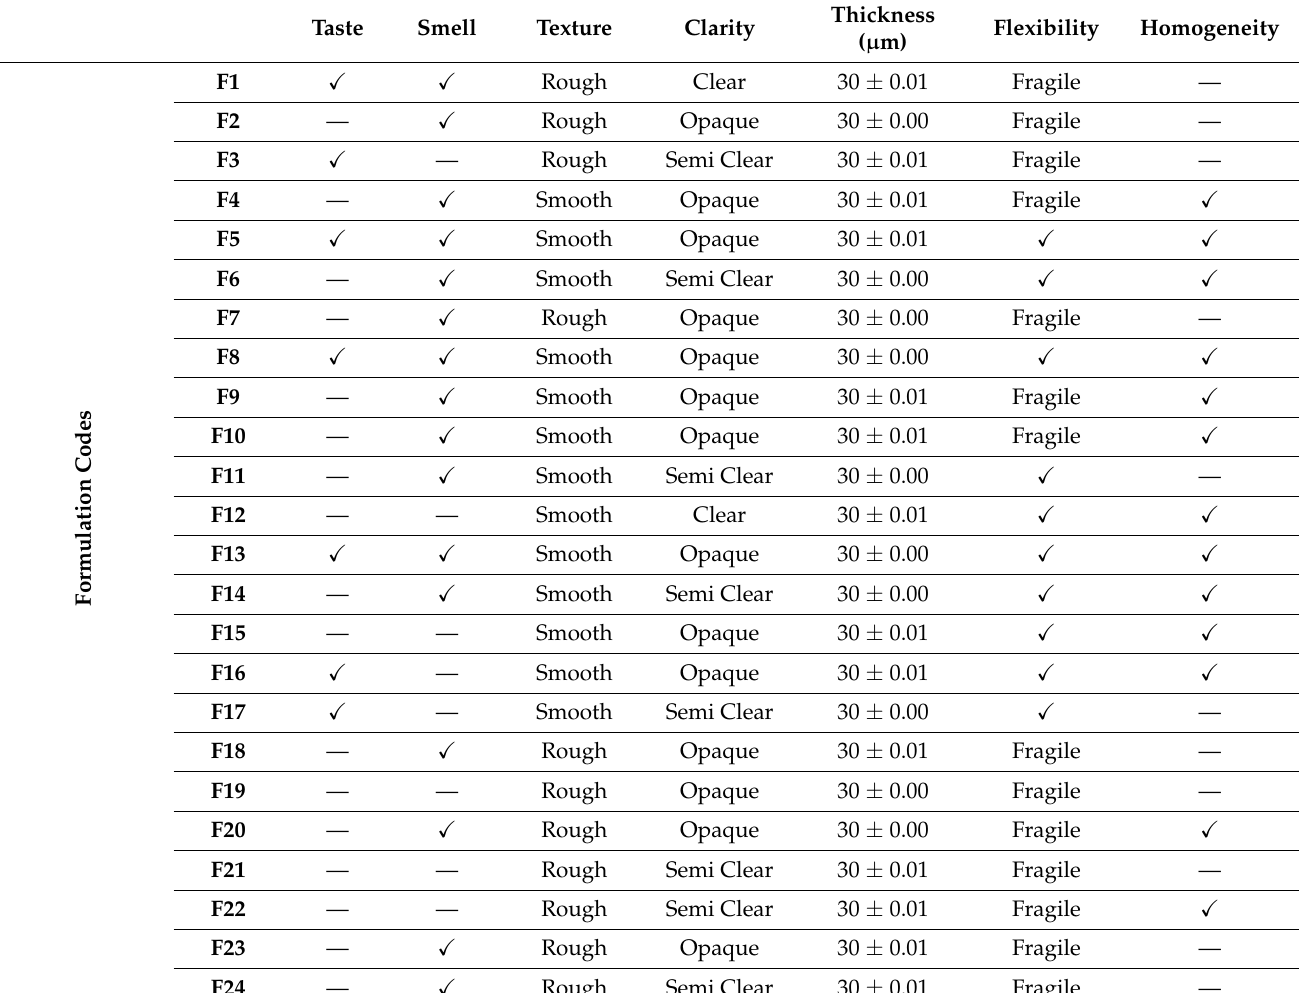
Table 4. Organoleptic evaluation of OTF